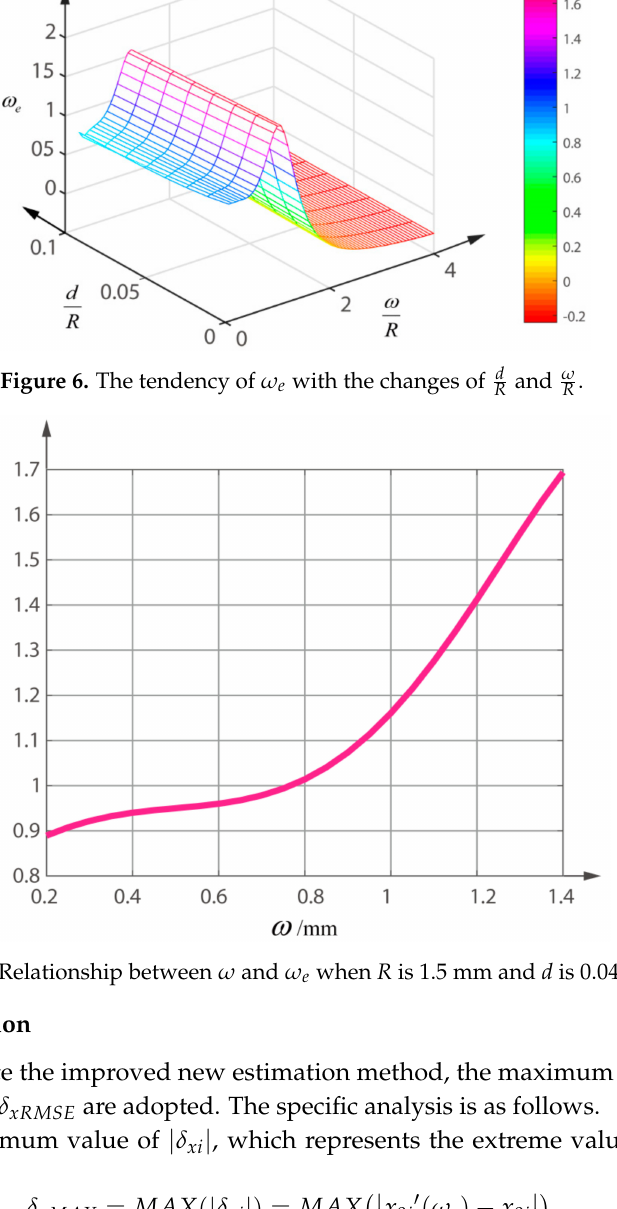
Figure 7. Relationship between ω and ω e when R is 1.5 mm and d is 0.045